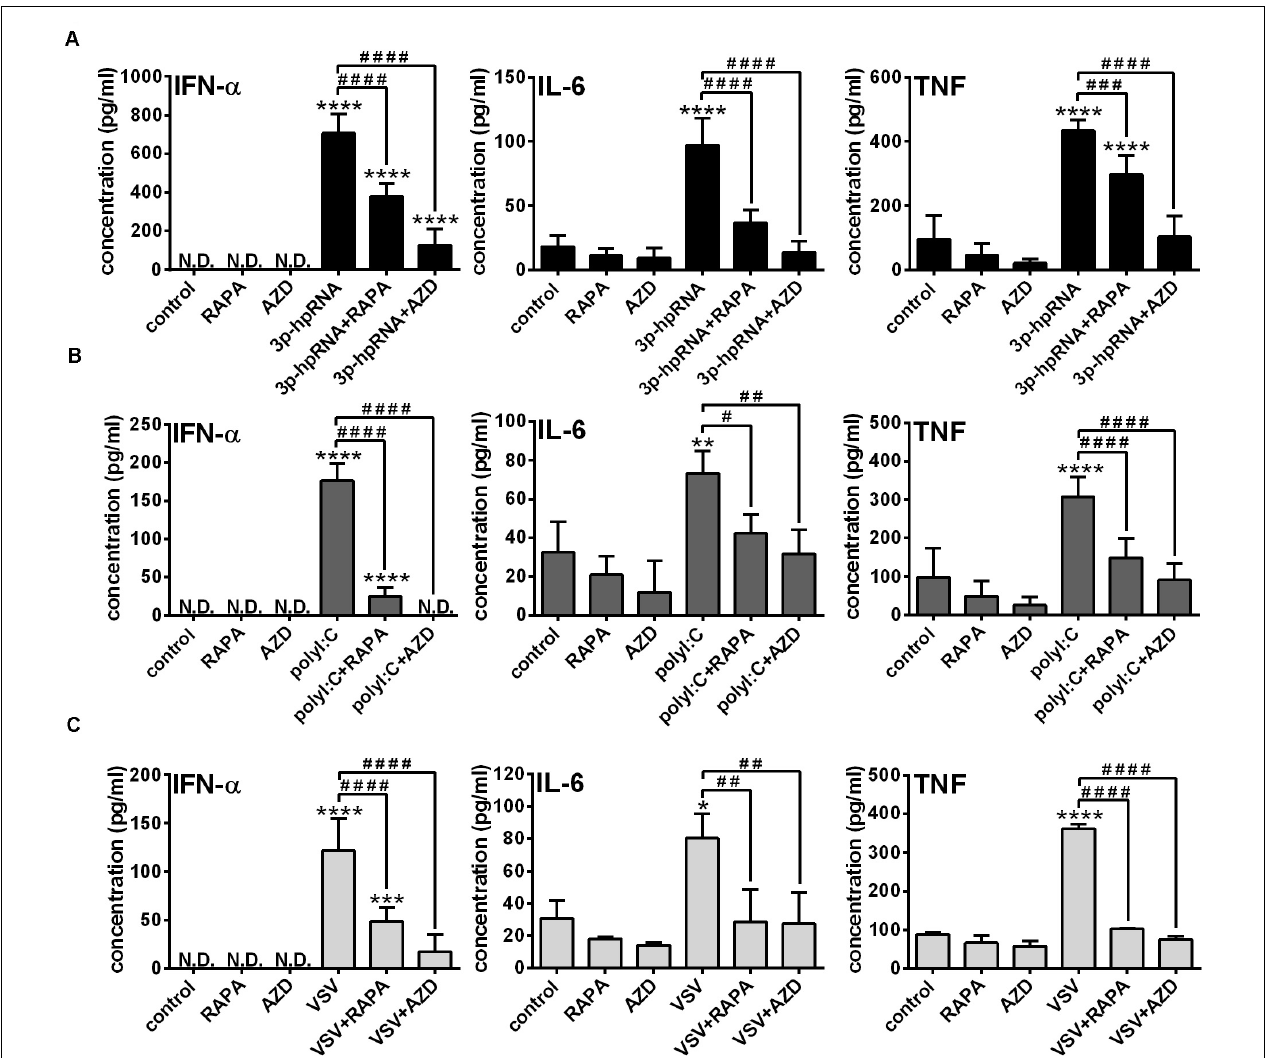
FIGURE 6 | The RLR-mediated production of IFN- α and pro-inflammatory cytokines is decreased upon mTOR inhibition in GEN2.2 cells. GEN2.2 cells were pre-treated with vehicle control, 100 nM rapamycin (RAPA) or 100 nM AZD8055 (AZD) for 2 h then stimulated with 3p-hpRNA (0.5 µ g/ml) (A) , polyI:C (1 µ g/ml) (B) , or VSV (MOI 1) (C) . (A–C) IFN- α , IL-6 and TNF protein levels were measured by ELISA 6 h after 3p-hpRNA as well as polyI:C activation and 18 h after VSV stimulation. Data are shown as mean ± SD from 4 to 8 independent experiments. * p < 0.05, ** p < 0.01, **** p < 0.0001 vs. control; # p < 0.05, ## p < 0.01, ### p < 0.001, #### p < 0.0001. ND, not